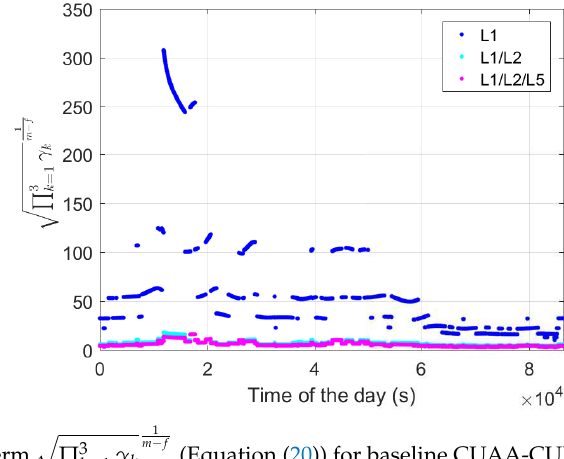
Figure 5. The term